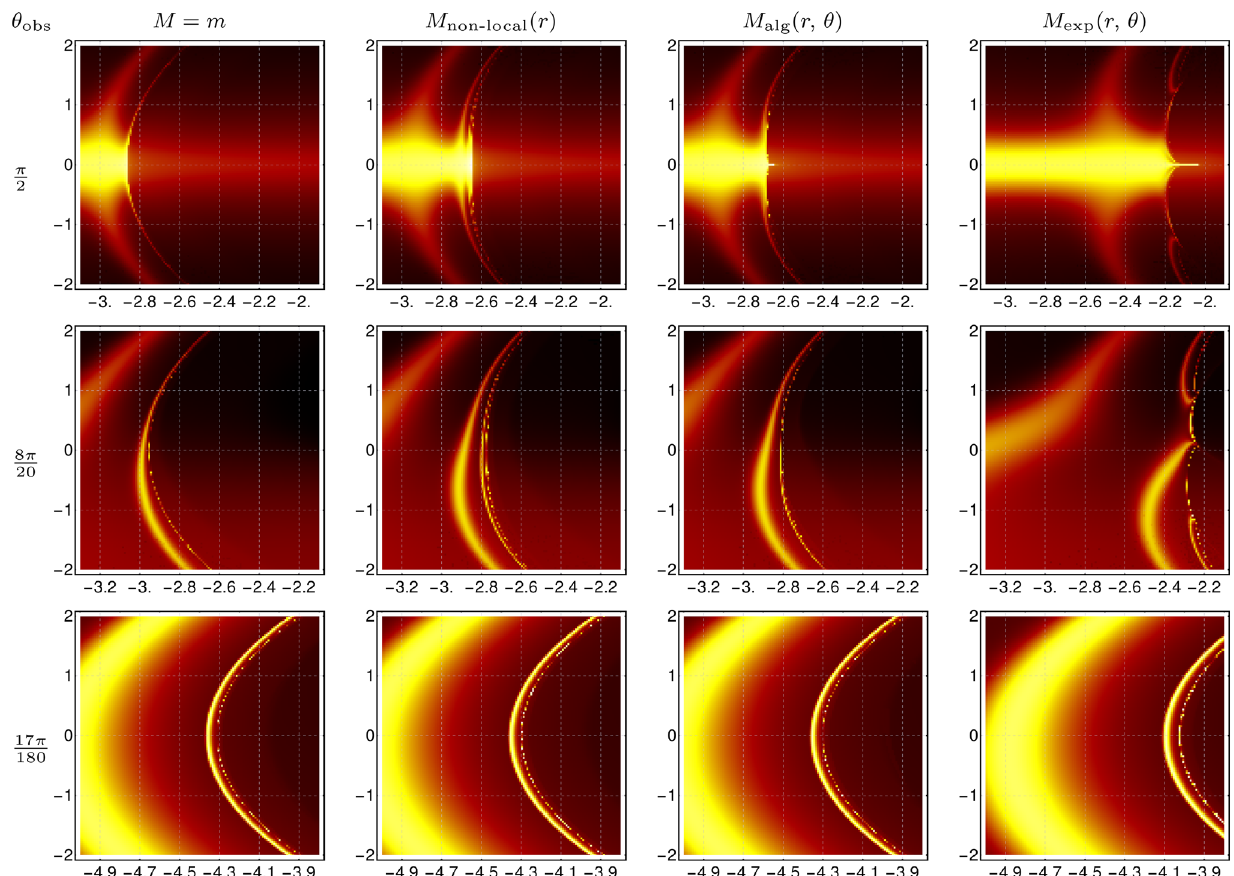
Fig. 3 Detailedintensityimagesoftheprograde sideofspinningblack holes ( a = 0 . 9 m ) in the ( x , y ) image plane, normalized to the bright- est image point (of all four images in each row), cf. color legend in Fig. 1. Columns from left to right correspond to mass functions M = m (Kerr), M non-local ( r ) (cf. Eq. (5)), M alg ( r , θ) (cf. Eq. (3)), and M exp ( r , θ) (cf. Eq. (4)), respectively. Apart from the Kerr case, the black-hole spacetimes are regular everywhere and, as in Fig. 2, (cid:11) NP is